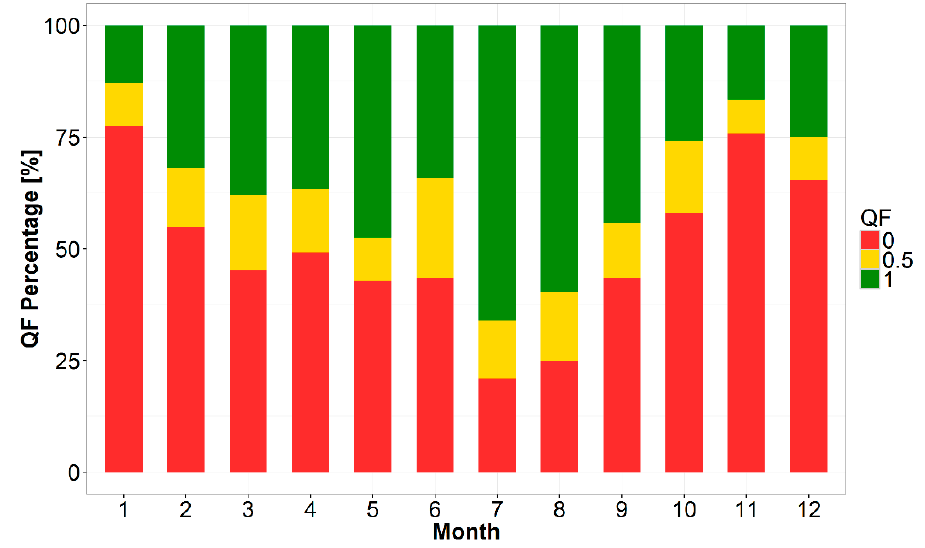
Figure A3. Presence in percentage of the three QF (QF1 best quality, QF0.5 intermediate quality, QF0 bad quality) over the two eddy towers for months.